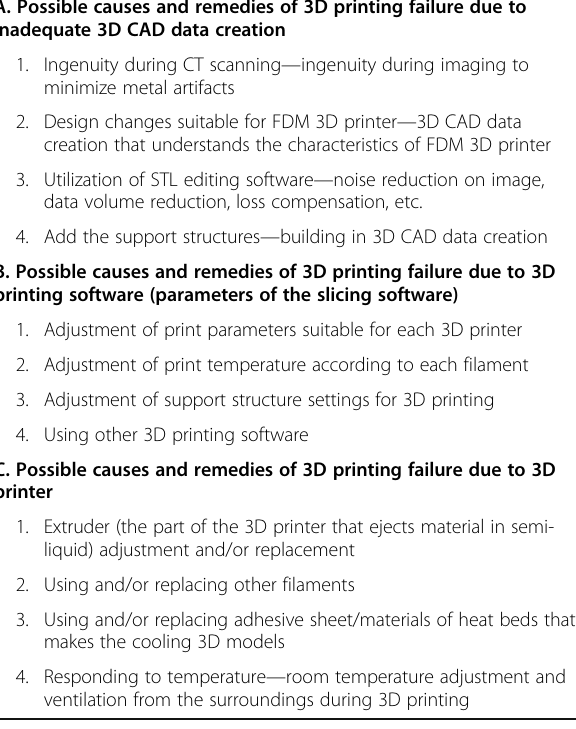
Table 1 Common problems encountered in 3D